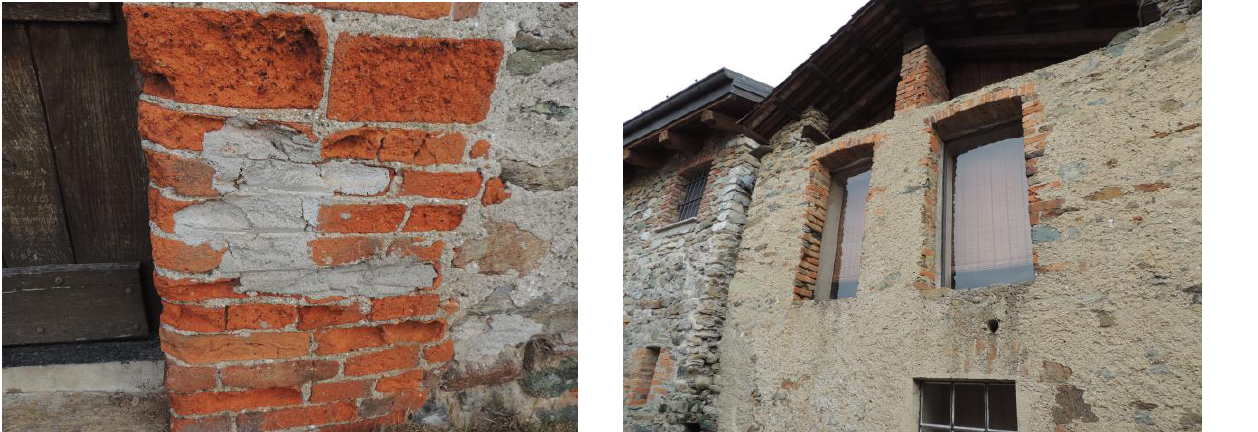
Figure 14. Building A - Reintegration of eroded bricks with cement mortar (credits Fabio Fratini).